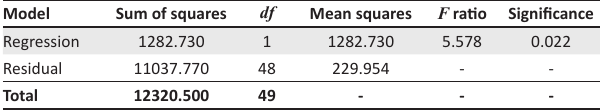
TABLE 4: Analysis of variance table (from